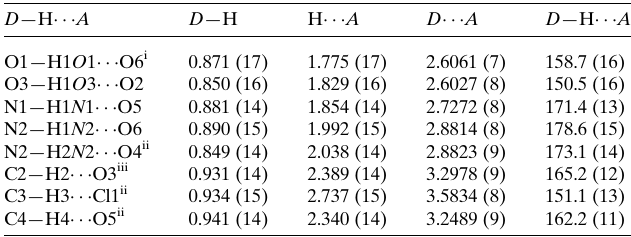
Table 1 Hydrogen-bond geometry (A˚ , (cid:4)